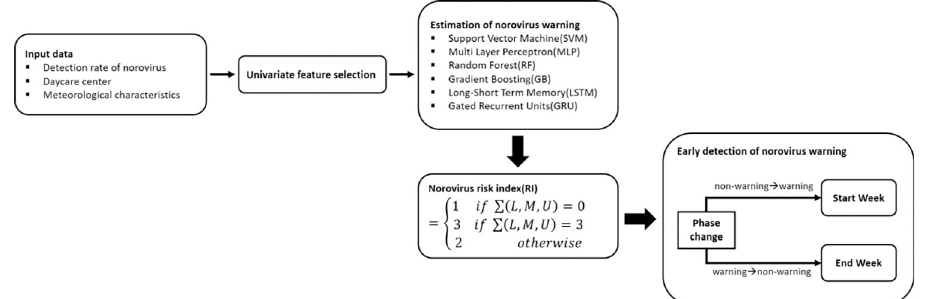
Fig 1. Schematic diagram illustrating how early detection of norovirus was predicted using the classification of machine learning and a risk index. L , M , and U denote the lower, average, and upper bounds of the confidence intervals of the norovirus warning,